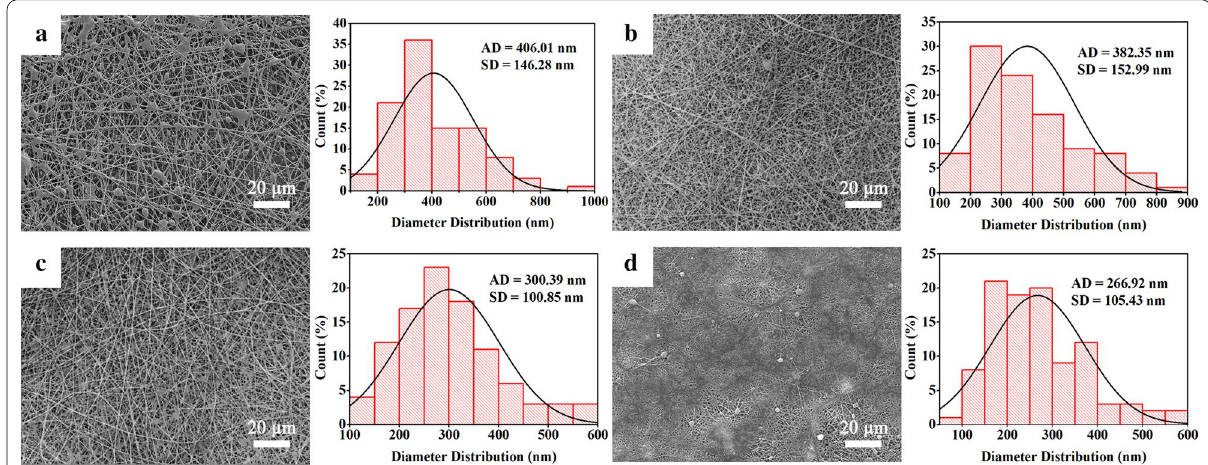
Fig. 2 SEM images and diameter distribution of CS@PG electrospun scaffolds at different ratios of CS. a PG, b 5%CS@PG, c 10%CS@PG, d 15%CS@